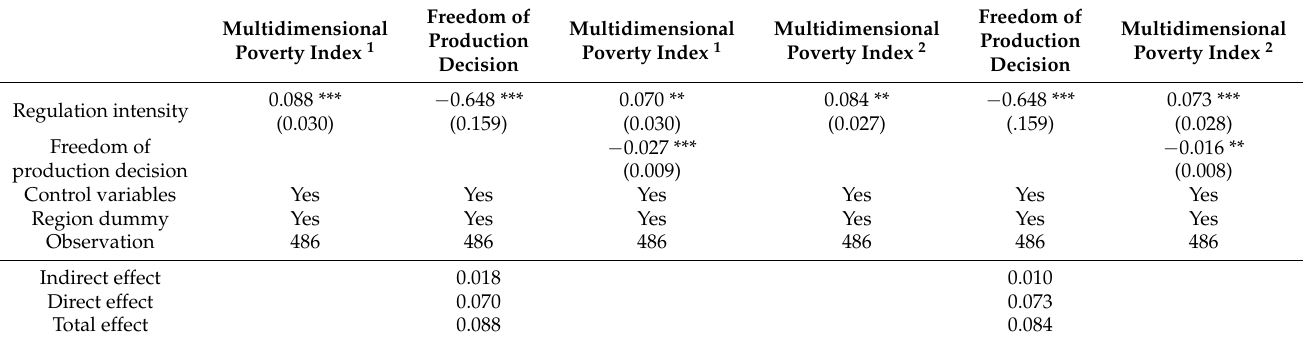
Table 10. Regulation in nature reserves vs. multidimensional poverty index of